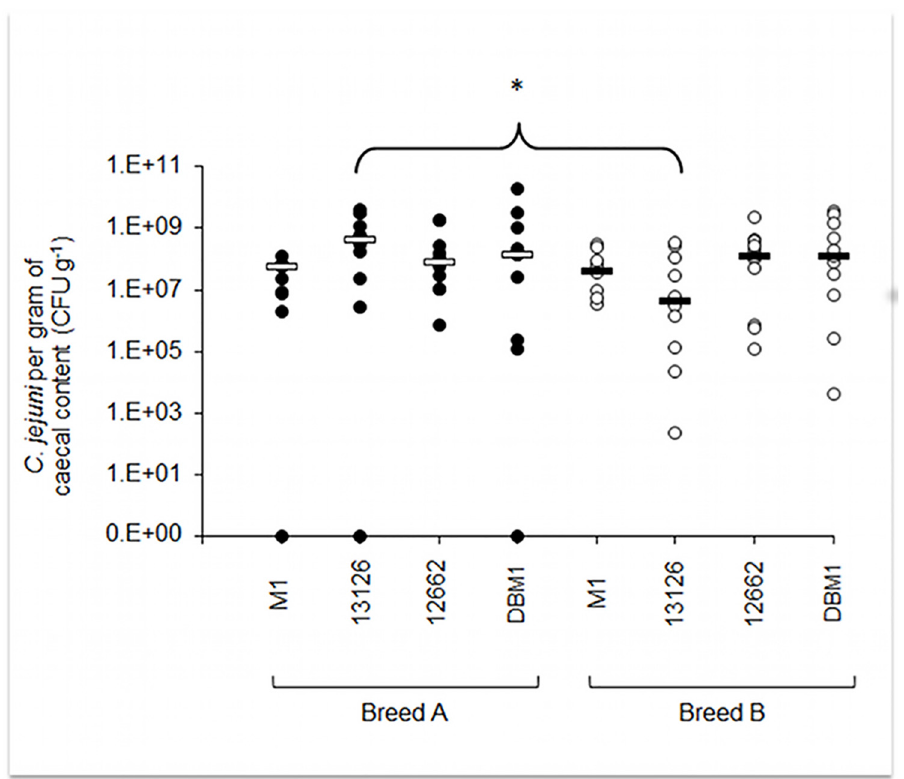
Fig 1. Caecal colonisation of two commercial broiler lines at 11DPI. Caecal colonisation of two broiler lines, A (closed circles) and B (open circles) by four C . jejuni strains. Bars represent the median value for each group. Asterisks show statistically significant differences in colonisation levels between the two broiler breeds as assessed by Mann Whitney U test ( * p = 0.0024).